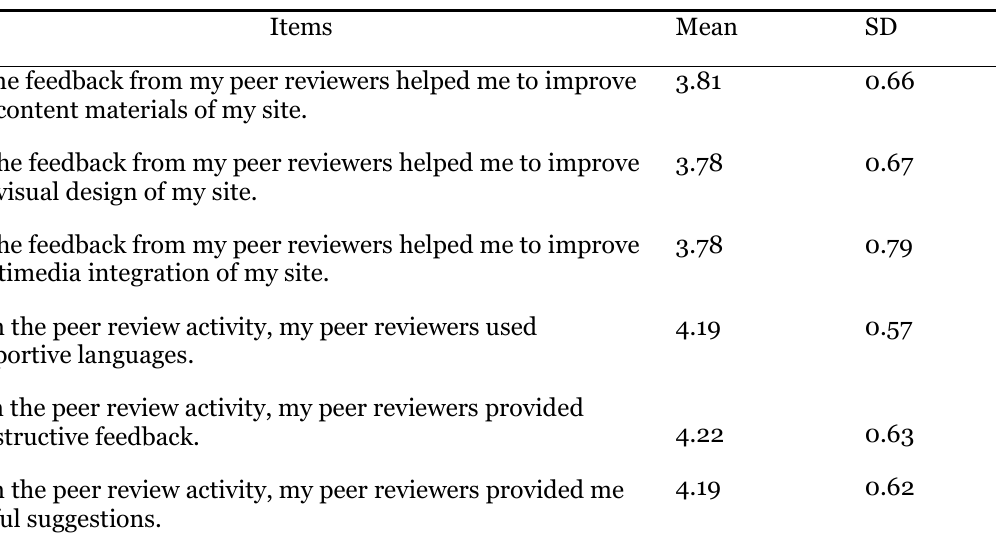
Participant Ratings on Perceptions of Feedback Received From the Peer Review Activity Items Mean